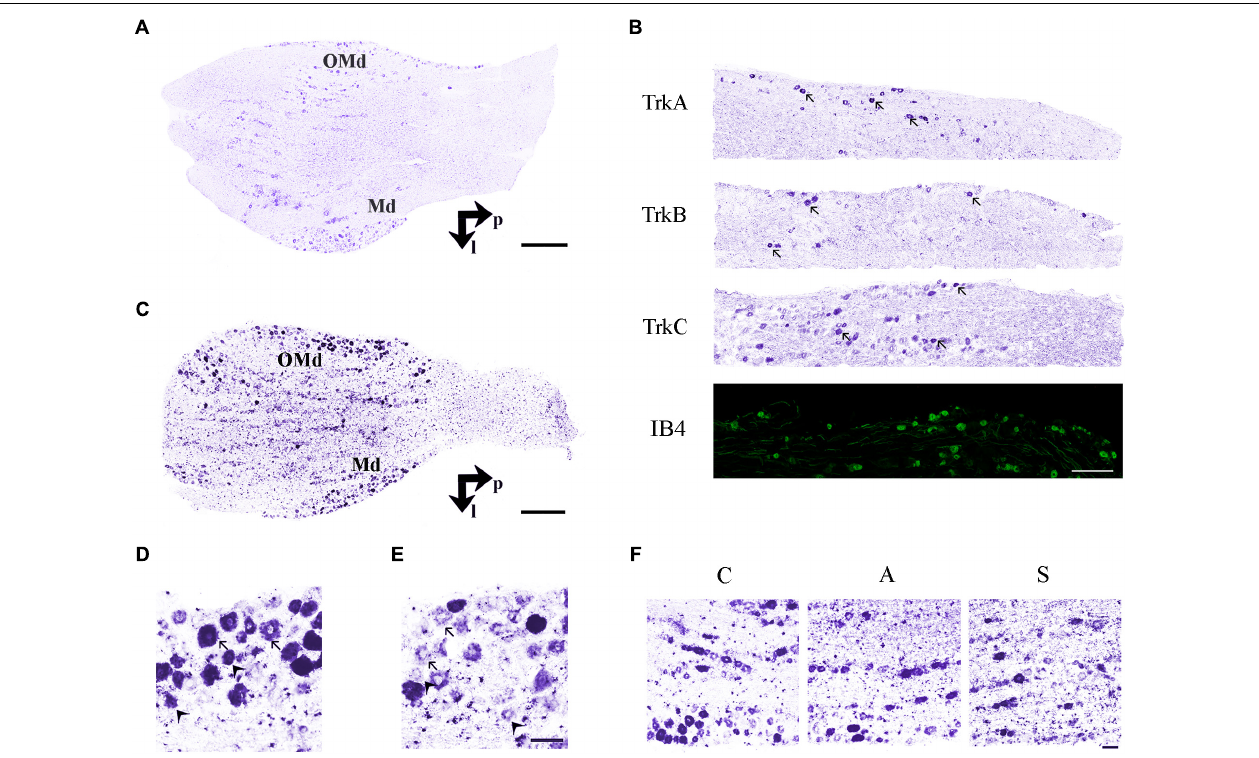
FIGURE 3 | (A) In situ hybridization using TrkB probe showing the histological architecture in a control TG. OMd, ophthalmic-maxillary division; Md, mandibular division; p, posterior; l, lateral. Scale bar = 100 µ m. (B) Panoramic microphotographs showing the distribution of neuronal subpopulations as defined by the expression of TrkA, TrkB, TrkC, and IB4 in a control TG. Arrows indicate positive neurons. Scale bar = 100 µ m. (C) In situ hybridization of RET proto-oncogene mRNA. OMd, ophthalmic-maxillary division; Md, mandibular division; p, posterior; l, lateral. Scale bar = 100 µ m. (D) Microphotographs for RET-positive neurons. Large diameter cells, Ø ≥ 20 µ m, were classified as putatively mechanoceptive or proprioceptive neurons (arrow) and small diameter ones, 8 µ m ≤ Ø < 20 µ m, as putatively thermo-nociceptive neurons (arrowhead). (E) Small and large RET-negative cells were also present in all RET-reacted slides. Scale bar = 50 µ m for both images. (F) Representative microphotographs of RET-positive neurons in the ophthalmic-maxillary division from C, A, and S animals. Scale bar = 50 µ m.